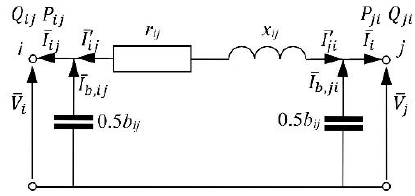
Figure 1. The π model of branch i - j .